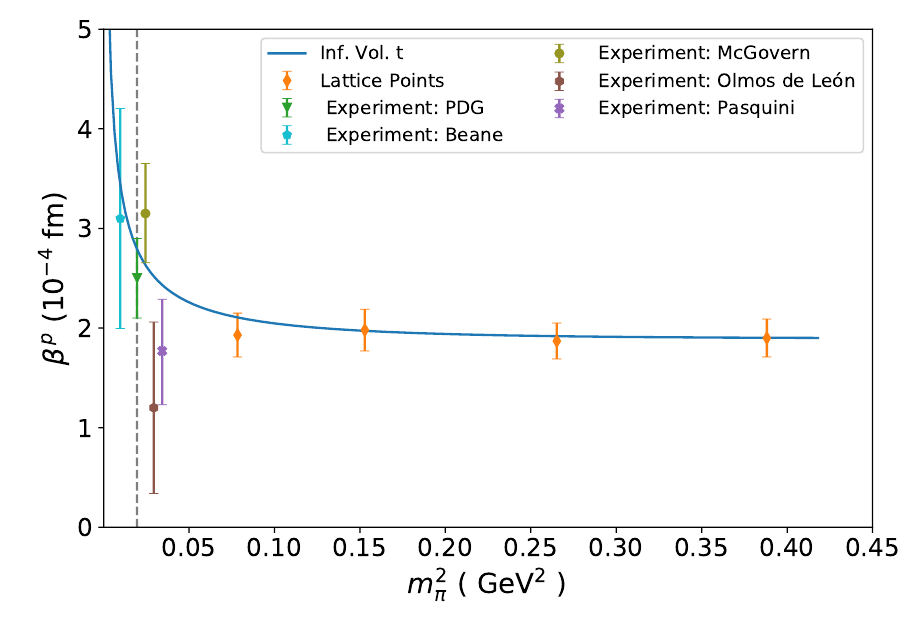
Figure 3. Experimental measurements of the magnetic polarisability of the proton, β p , from the PDG [4], McGovern et al. [5], Beane et al. [24], Blanpied et al. [2], Olmos de León et al. [25], MacGib- bon et al. [1] and Pasquini et al. [3] are o ff set for clarity and compared with the lattice QCD results produced herein. The finite-volume and electro-quenched corrected chiral extrapolation of Ref. [21] is also illustrated by the curve ( Inf. Vol. t ) for comparision with